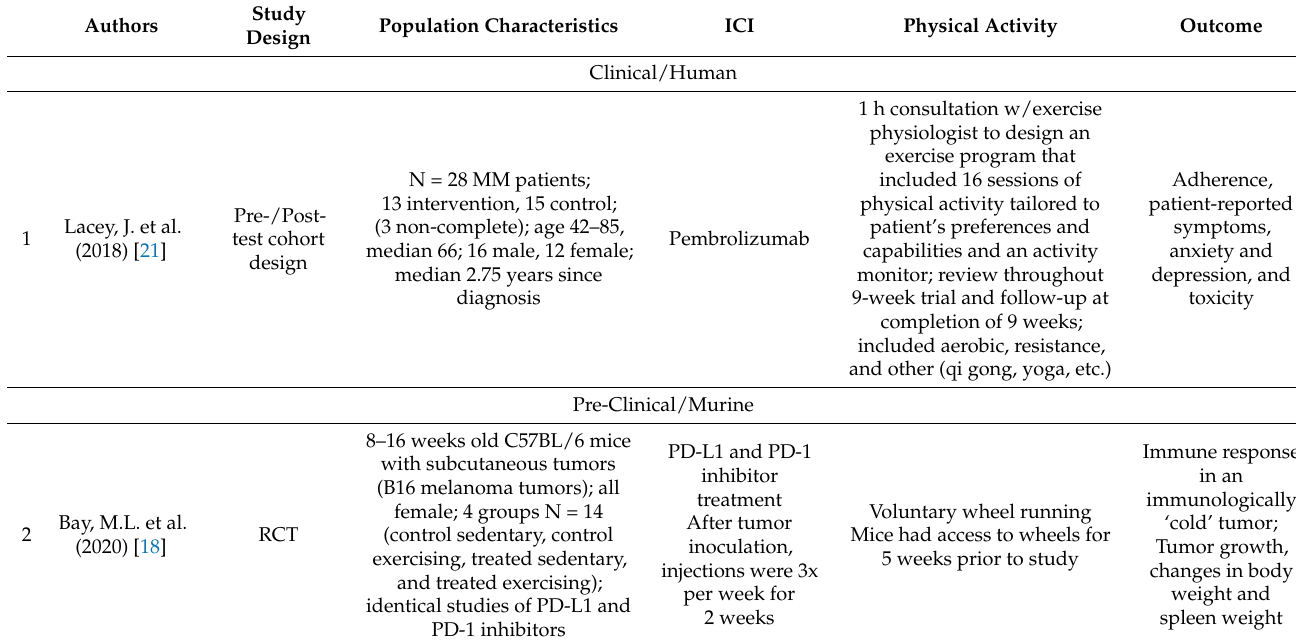
Table 1. Selected study characteristics.